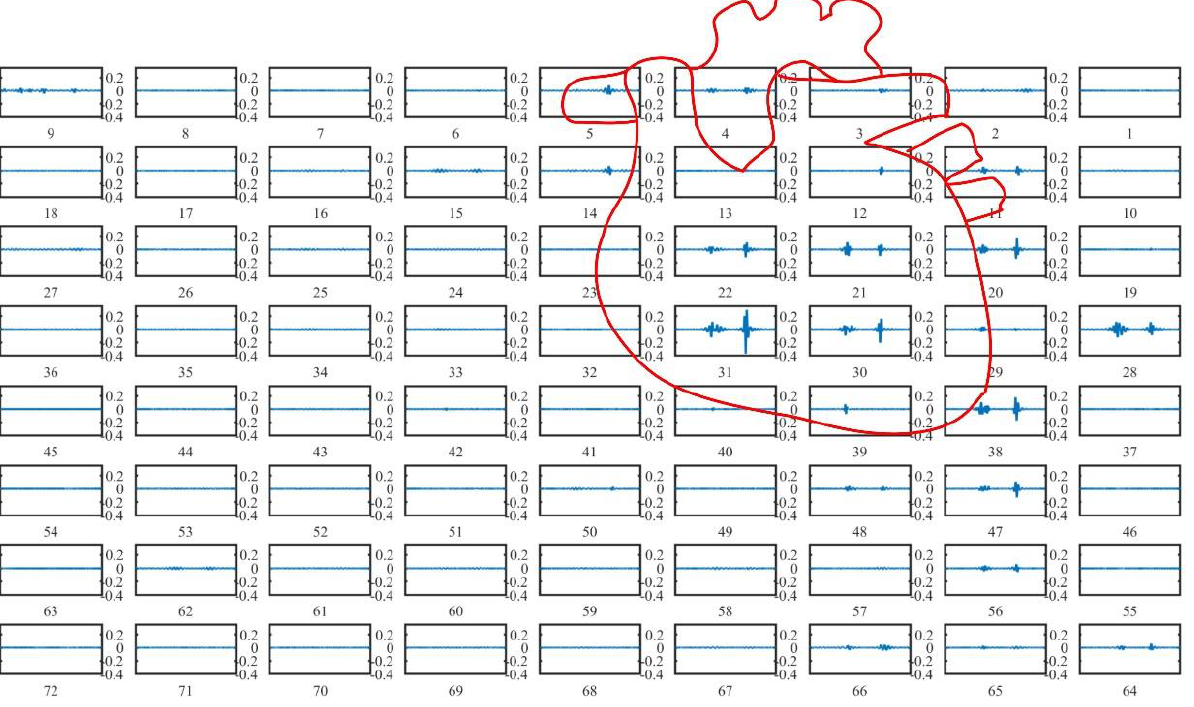
Figure 10. 72 − channel heart sound signals at the chest surface of a 27 − year − old healthy male of Figure 10. 72-channel heart sound signals at the chest surface of a 27-year-old healthy male of height height 183 cm and weight 65 kg. 183 cm and weight 65